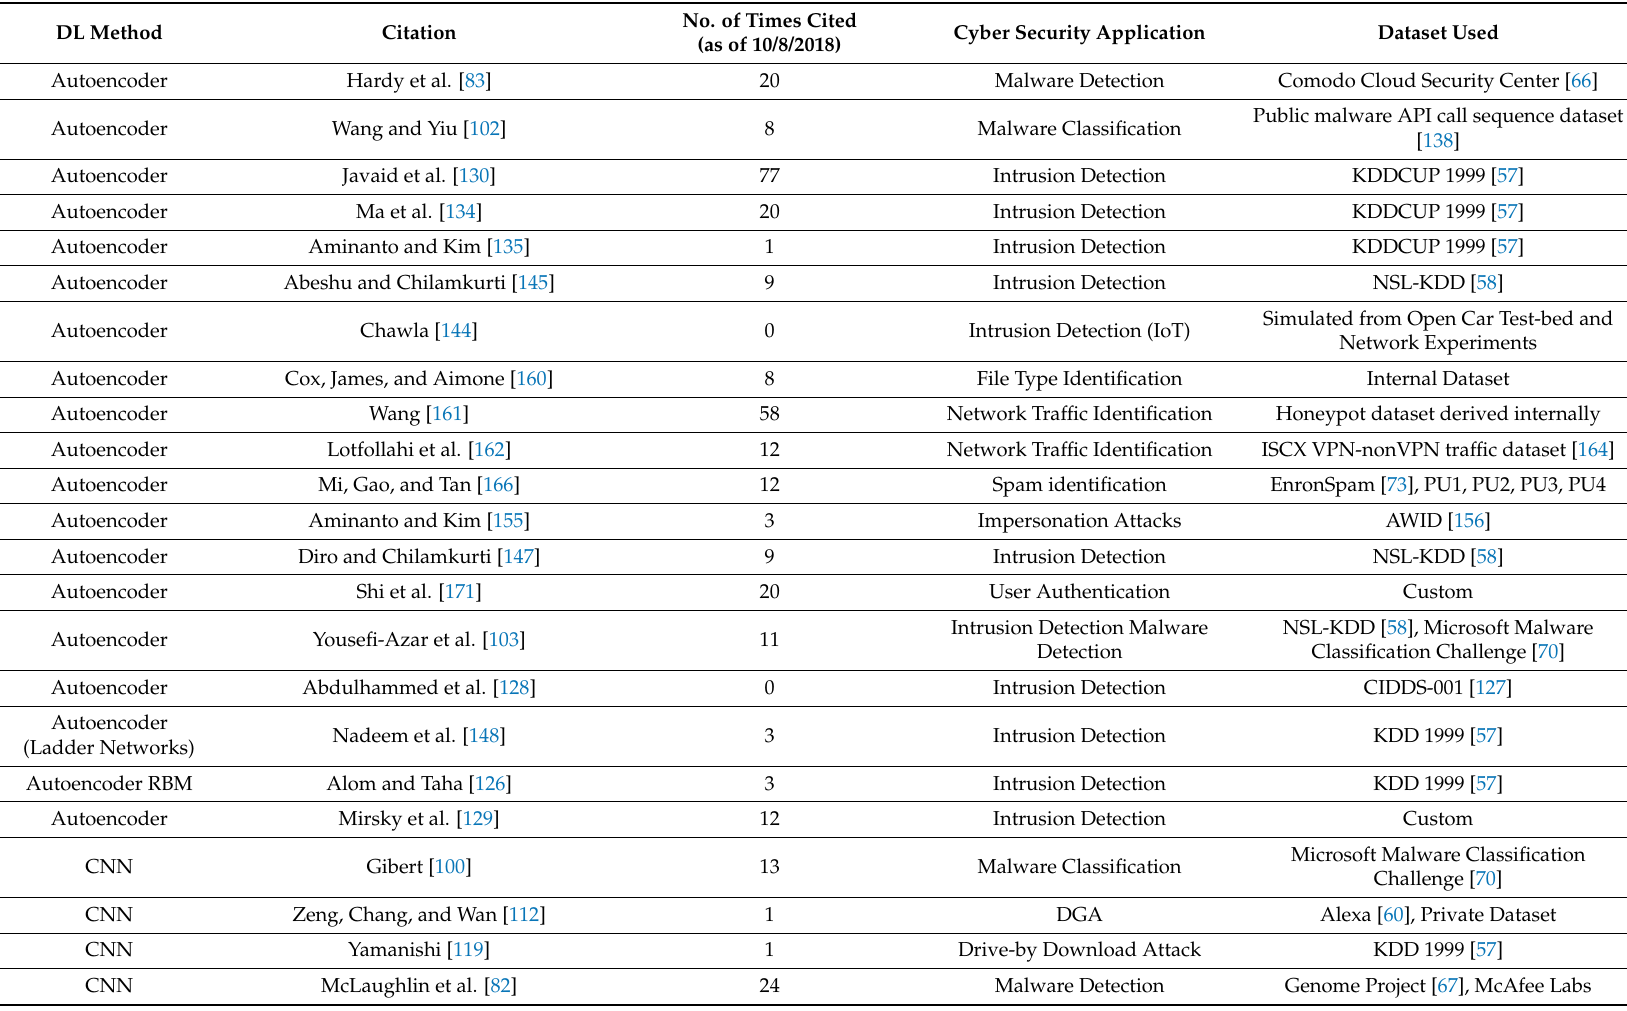
Table 2. List of Deep Learning approaches surveyed highlighting the DL method, cyber security application, and the dataset